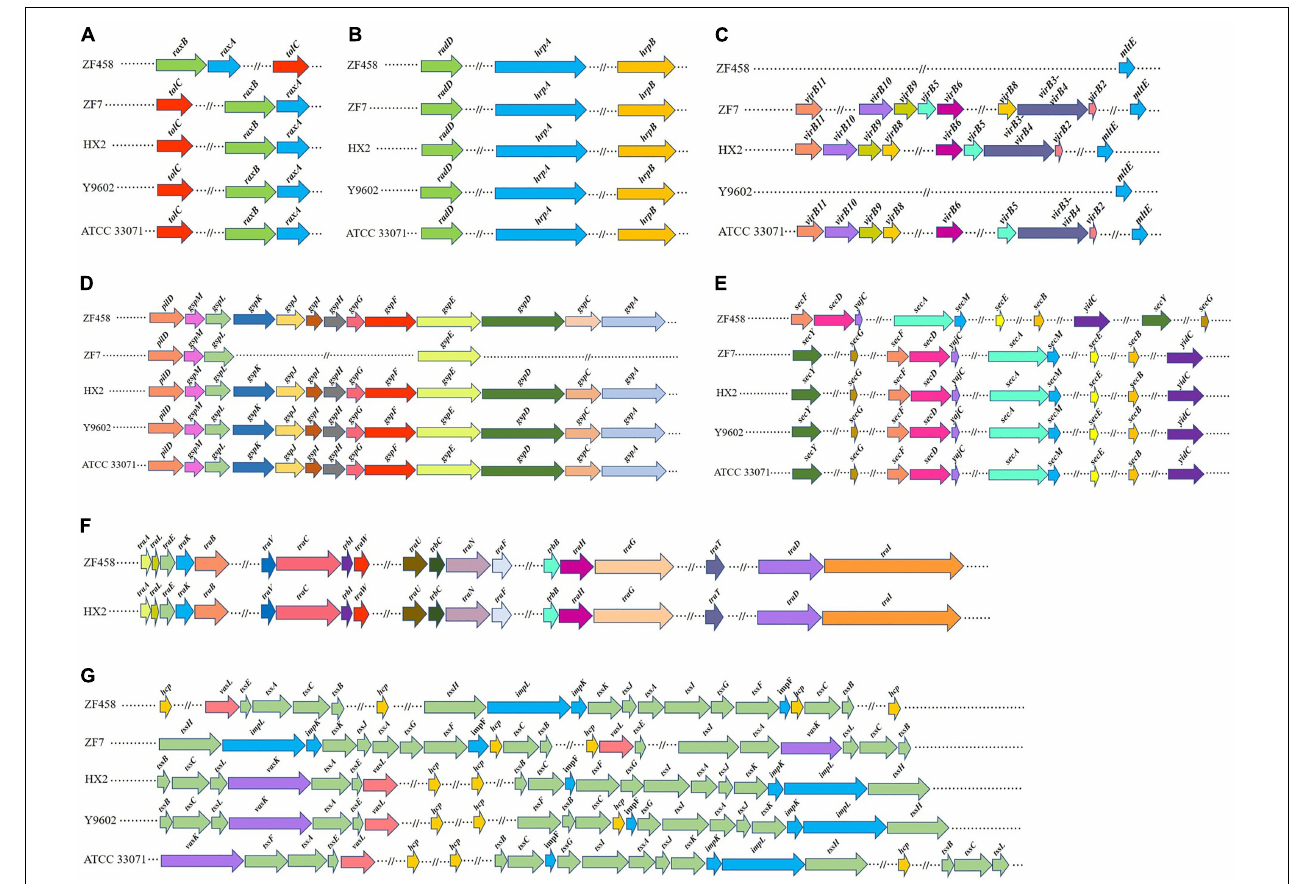
FIGURE 4 | Comparison of the bacterial secretion system gene clusters of R. aceris ZF458 against four previously fully sequenced Rahnella genomes. (A) Type I secretion system. (B) Type III secretion system. (C) Type IV secretion system. (D) Type II secretion system. (E) Sec (secretion) system. (F) Conjugal transfer region of type IV secretion. (G) Type VI secretion system. The same color represented genes with the same or similar biological function. Arrows denoted putative transcriptional units. The length of blocks represented the size of genes (1 cm = 1000